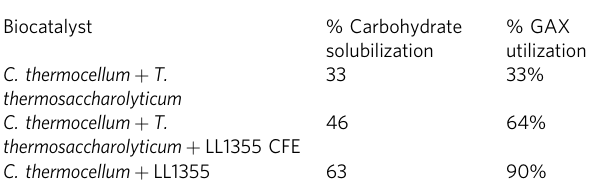
Table 5 Fermentations on 40 g/L corn fi ber using various